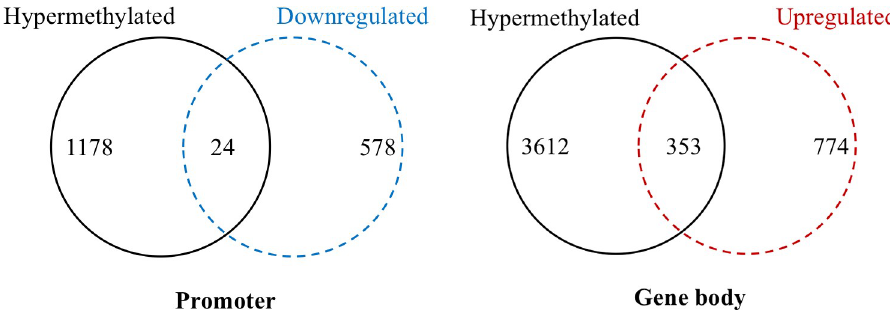
Fig 2. Integrative analysis of genes with differential hypermethylation and differential expression in the promoter and gene-body regions in CLBL-1 8.0. (A) The total number of hypermethylated/downregulated genes in promoter regions. A total of 24 genes were hypermethylated and downregulated in expression. (B) The total number of hypermethylated/upregulated genes in the gene-body areas. A total of 353 genes were hypermethylated and upregulated in